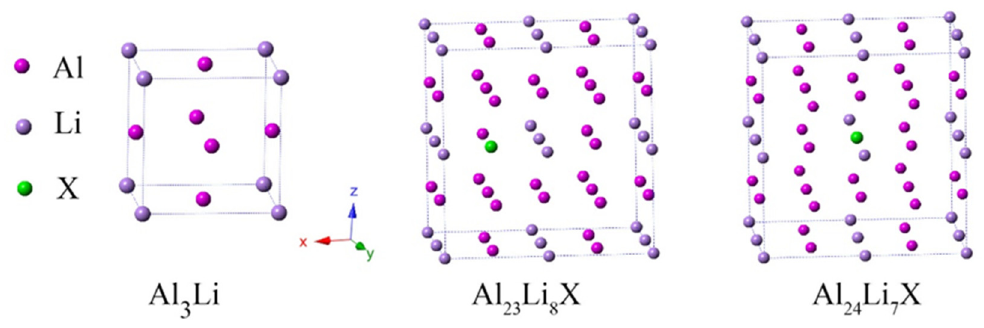
Figure 1. Crystal structure of Al 3 Li, Al 24 Li 7 X and Al 23 Li 8 X (X = Zn, Zr and